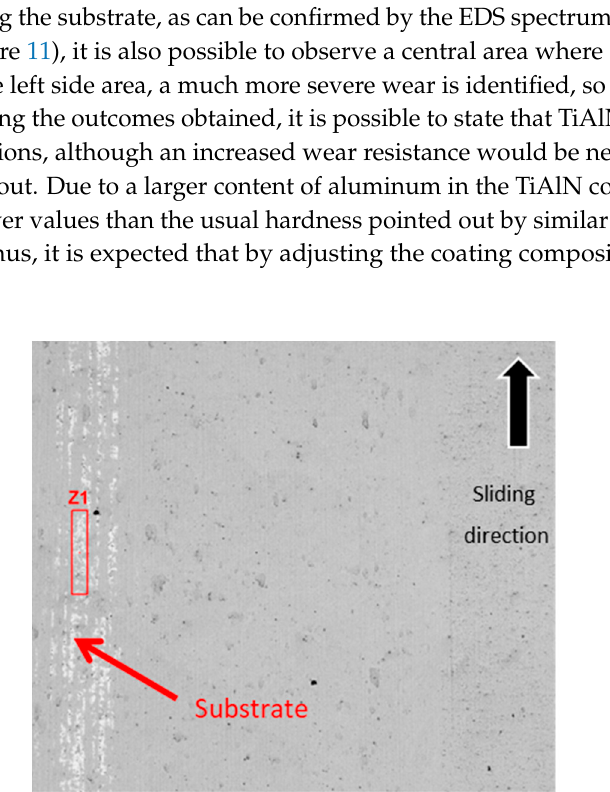
Figure 12. Spectrum of the TiAlN surface at area Z1.